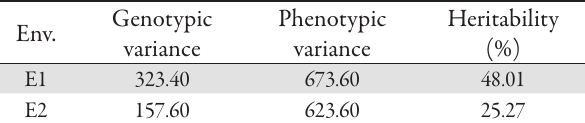
Tab. 3. Heritability estimates for grain yield in rice under two water stress environments (E1 and E2)